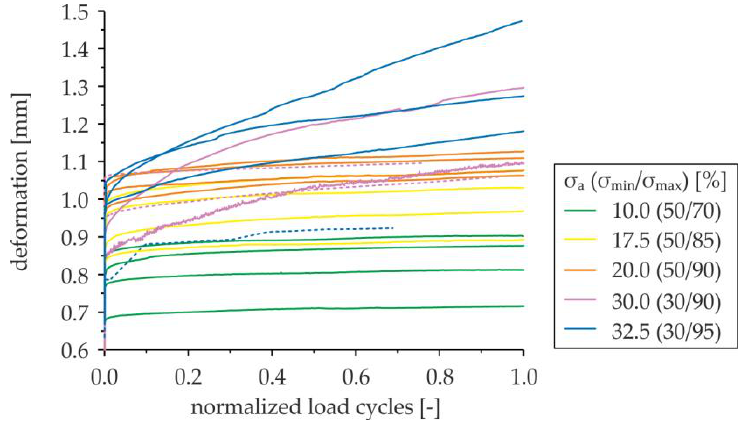
( b ) Figure 7. Comparison of normalized cyclic creep curves depending on the load level (here: anchorage length = 3 a ): ( a ) 30% minimum stress; ( b ) 50% minimum stress. One can see that deformations become larger with increasing maximum stress. However, not